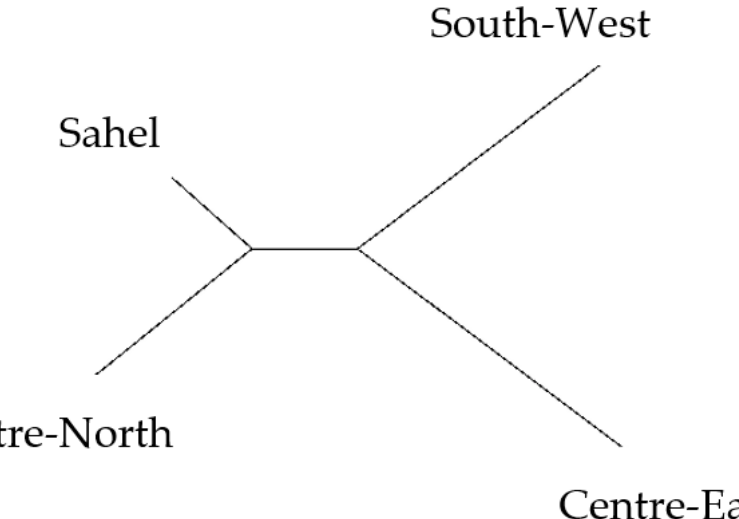
Figure 2. Unrooted consensus tree constructed using standard genetic distance (Nei, 1972) describing the relationships between local chickens in the Centre-East (Konde ecotype), Centre-North, Sahel and South-West regions of Burkina Faso.